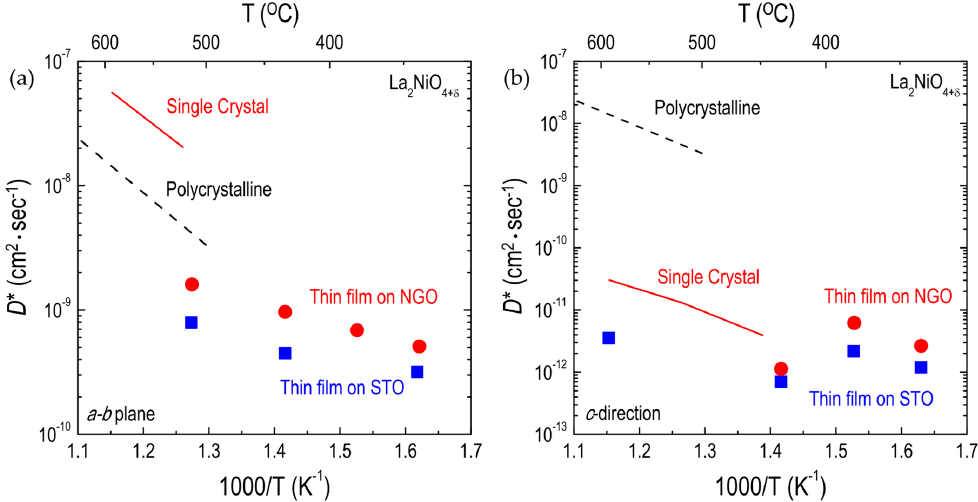
Figure 9. Arrhenius plots of oxygen tracer diffusivity ( D *) for La 2 NiO 4+ δ films: ( a ) D * along the a-b plane; and ( b ) along the c -direction for La 2 NiO 4+ δ films on SrTiO 3 (STO) and NdGaO 3 (NGO). Thin film [58], single-crystal [97], and polycrystalline [51] data are comparatively